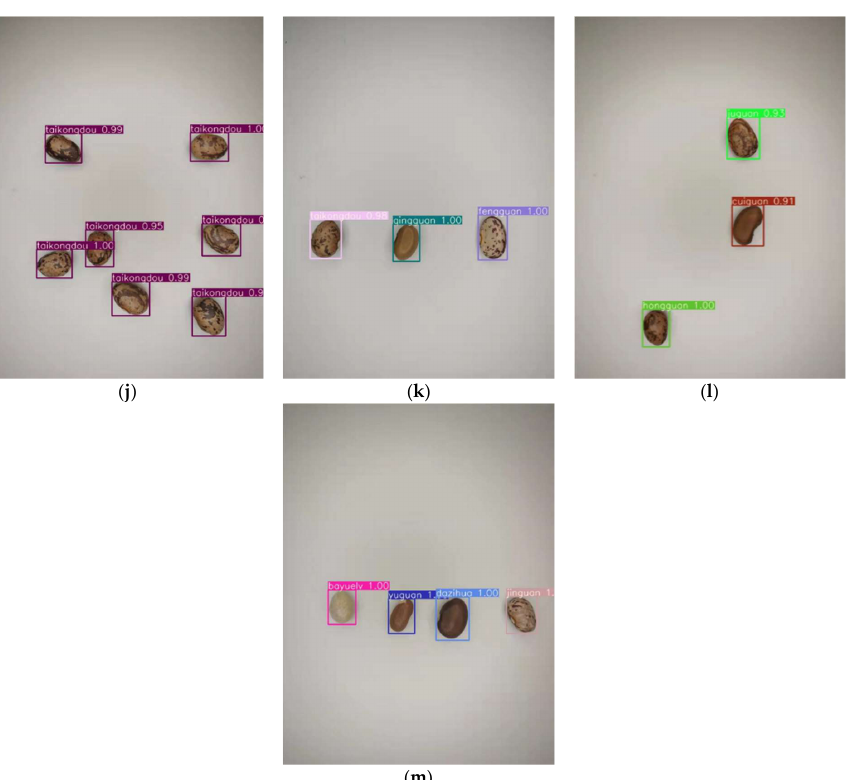
Figure 14. ( a – j ) The detection results for ‘juguan’, ‘fengguan’, ‘jinguan’, ‘bayuelv’, ‘yuguan’, ‘cuiguan’, ‘qingguan’, ‘dazihua’, ‘hongguan’, and ‘taikongdou’. ( k – m ) The detection results for ran- dom combinations of different classes of seeds.